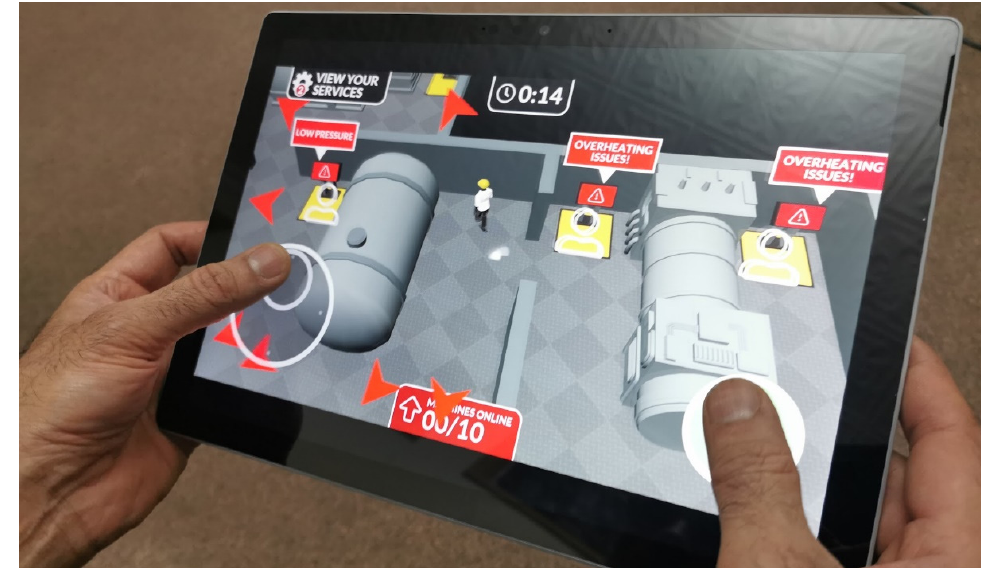
Figure 5. Screen capture of player racing against the clock to maintain the production.